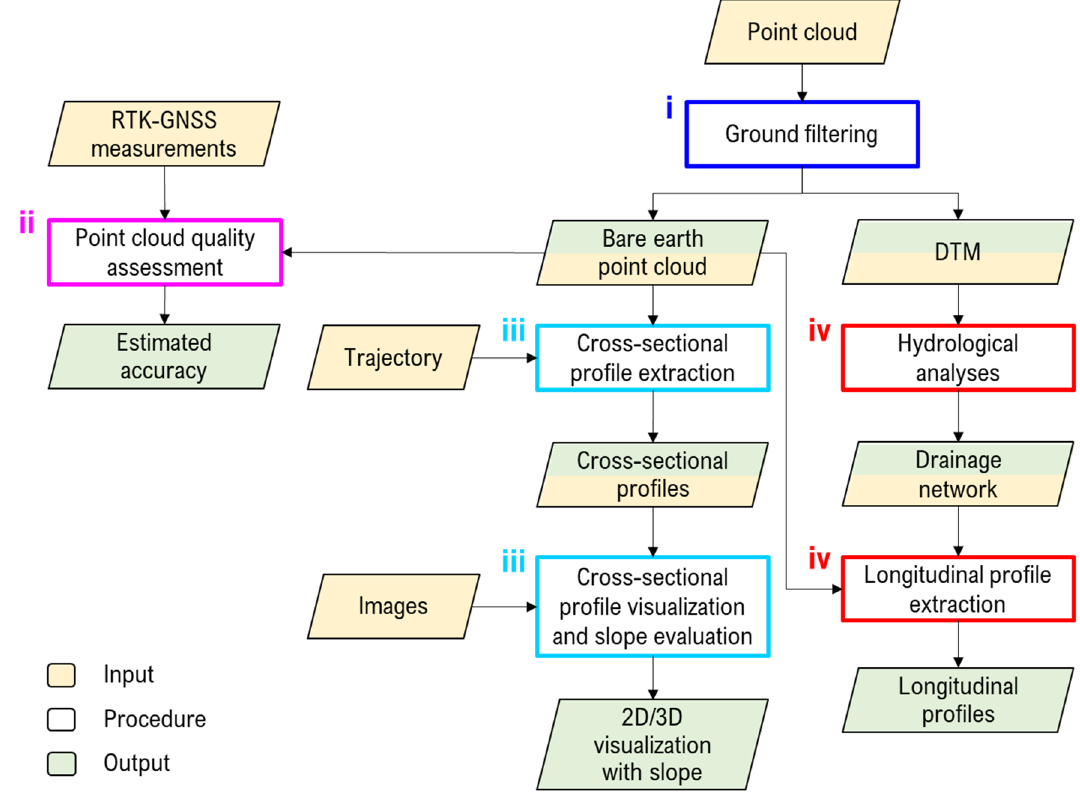
Figure 5. Main steps of the proposed framework for point cloud quality assessment and ditch mapping/characterization.